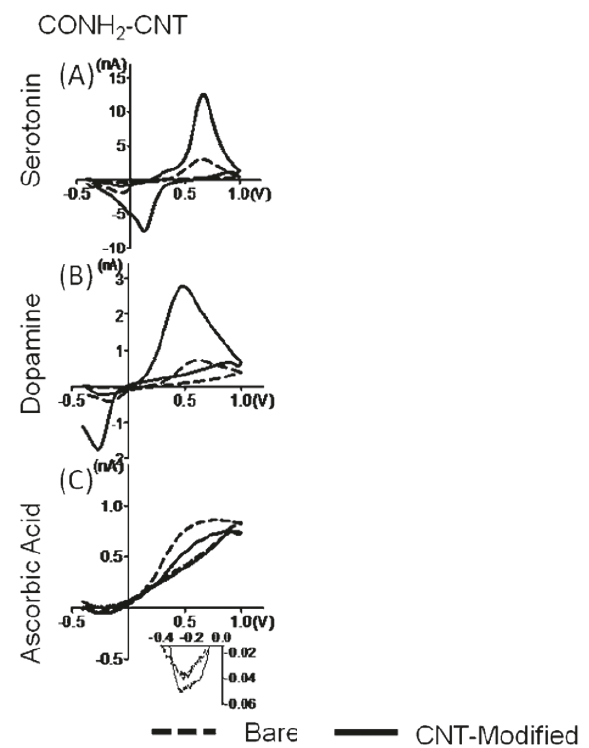
Figure 11: Representative cyclic voltammograms from electrodes before (dashed lines) and after modification with carbon nanotubes (solid line). Vertical columns compare types of functionalized nanotubes: amide-CNTs (panels (A)–(C)), carboxylic acid-CNTs. Figure reproduced with permission from